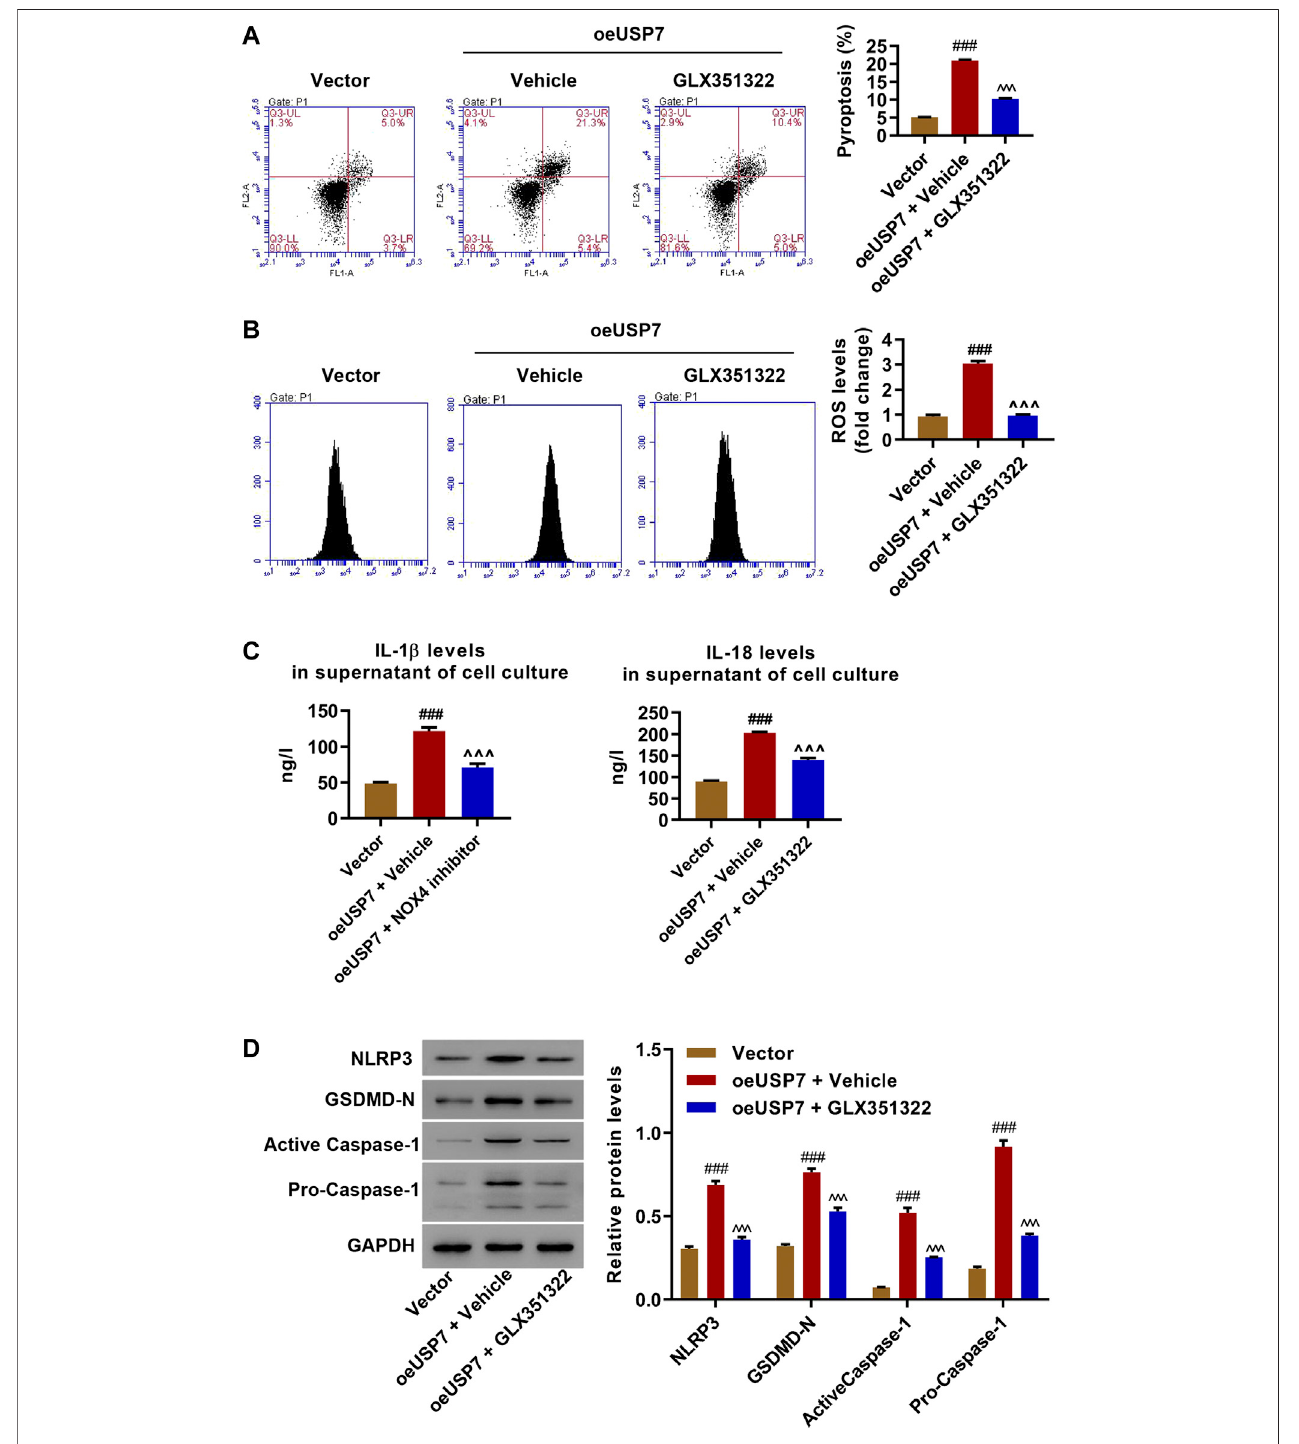
FIGURE5| Theeffect ofUSP7overexpressionwasabolishedbyinhibition ofNOX4.Rat chondrocytes weretransducedwithUSP7expression vectorandtreated with the NOX4 inhibitor GLX351322 (10 μ M), and (A) pyroptosis, (B) ROS levels, (C) IL-1 β and IL-18 levels, and (D) expression levels of NLRP3, GSDMD-N, active caspase-1, and pro-caspase-1 was measured by fl ow cytometry, ELISA and Western blot, respectively. ### p < 0.001 vs vector; ^^^ p < 0.001 vs oeUSP7 + vehicle.